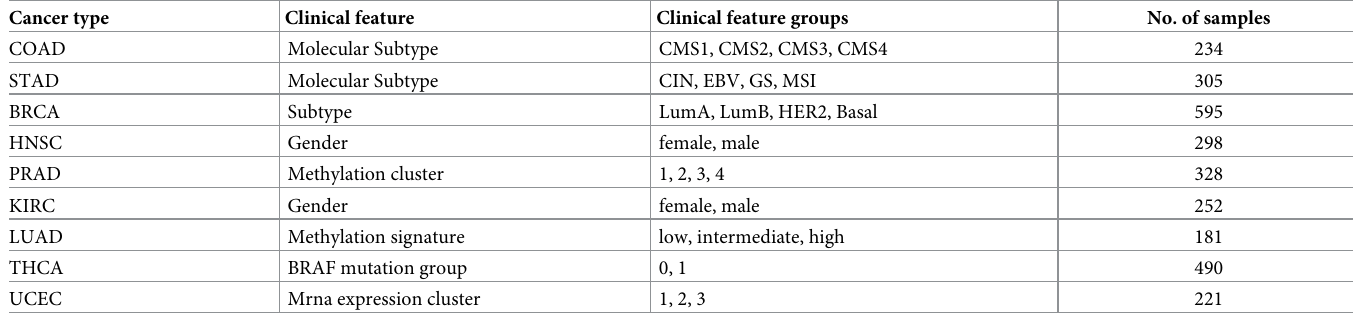
Table 2. A subset of the cancer